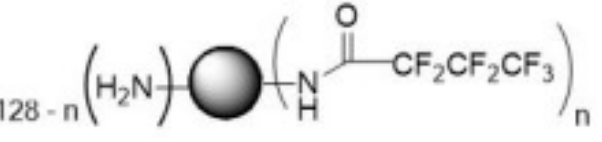
Figure 4. Fluorinated PAMAM G5.